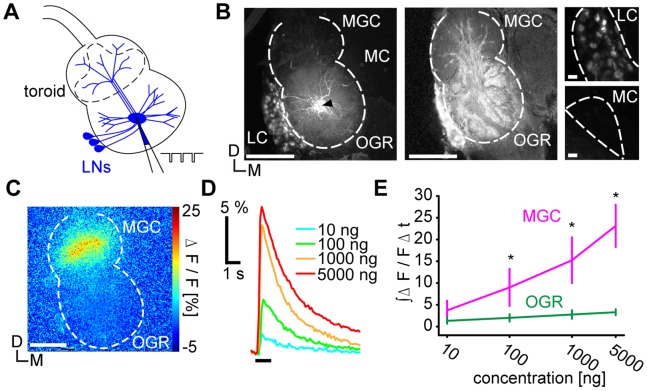
Calcium responses of local interneurons (LNs) to bombykol stimuli.
A, Schematic diagram of loading the calcium indicator into LNs with a micropipette by local electroporation. The toroid glomerulus is delineated by a dashed line. B, Two-dimensional projection of confocal sections (left, extending over 180 µm from the AL surface) and a single confocal optical section (middle) of labeled LNs. Scale bars: 100 µm. The arrowhead in the projection image indicates the injection site. LN branches innervating the MGC are resolved in the optical section. Stack projection images of the medial cell cluster (MC, right, top, extending over 60 µm in depth) and the lateral cell cluster (LC, right, bottom, extending over 60 µm in depth) are enlarged. Brightness and contrast of the images were adjusted at the same level for both cell clusters. The outlines of both cell clusters are delineated by dashed lines. Scale bars: 10 µm. C, Representative calcium response of LNs to 5000 ng bombykol in false colors. D, Representative time courses of LN calcium responses, same sample as in (C). Black bar under time courses indicates stimulus. E, Concentration-response characteristics of LNs in MGC (magenta) and in the OGR (green). Calcium responses were integrated over 3 s following stimulus onset (*: P<0.05, between both regions at given concentration, n = 7, Wilcoxon signed-rank test, means±SEM). D: dorsal, M: medial, MGC: macroglomerular complex, OGR: ordinary glomerular region. The outline of the AL is delineated by dashed lines.